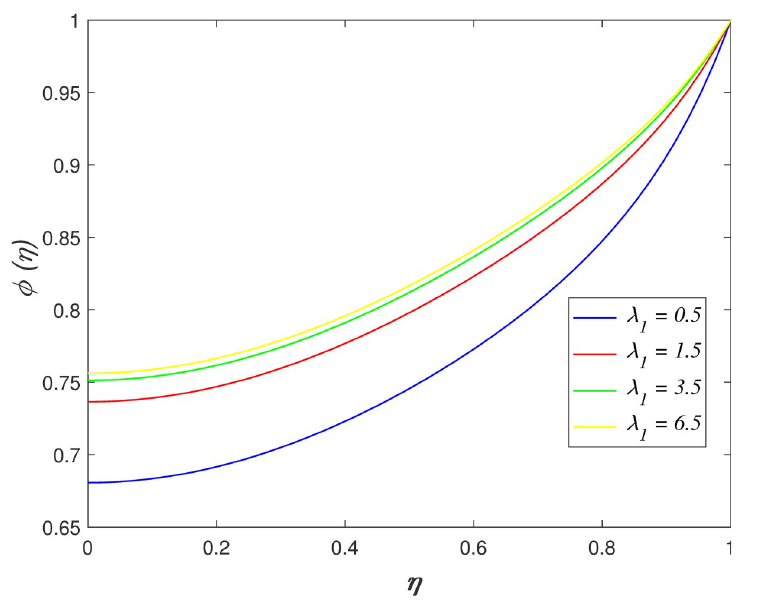
Fig 9. Impact of λ 1 on concentration.